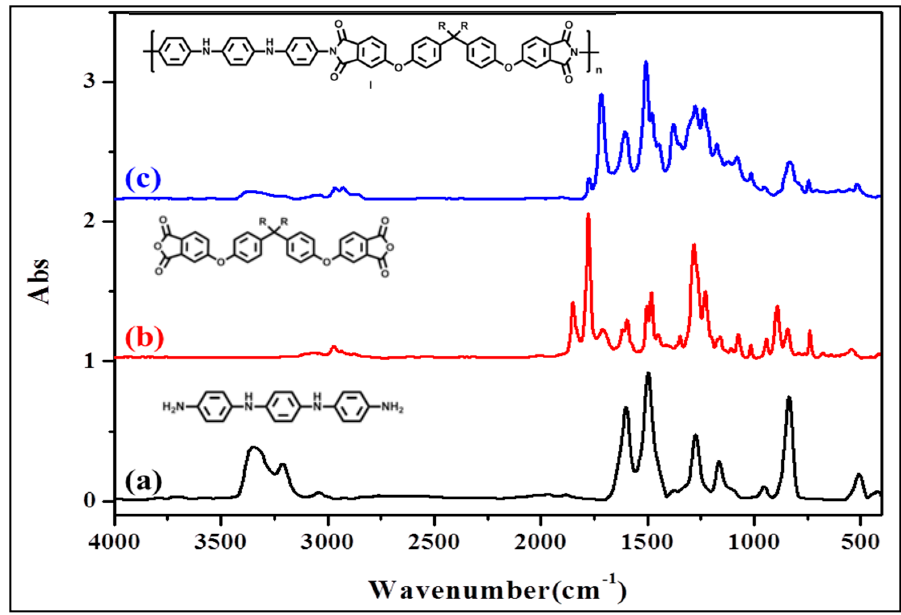
Figure 3. FTIR spectra of ( a ) synthesized ACAT, ( b ) BSAA, ( c ) synthesized electroactive PI.